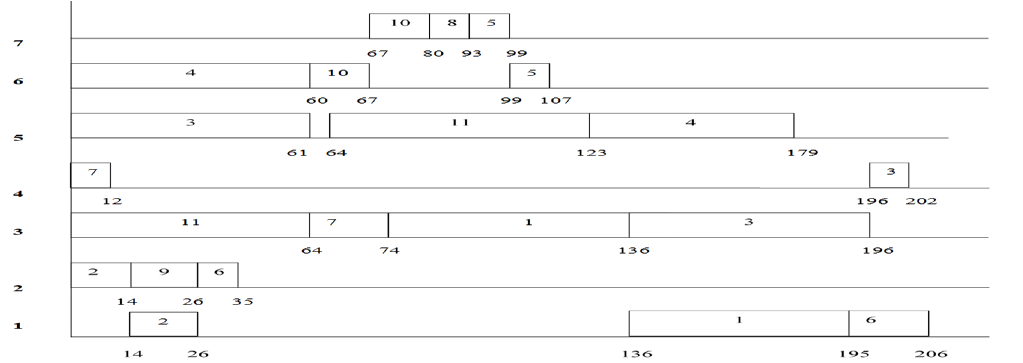
Fig. 4: Gantt Chart (Zeb et al.